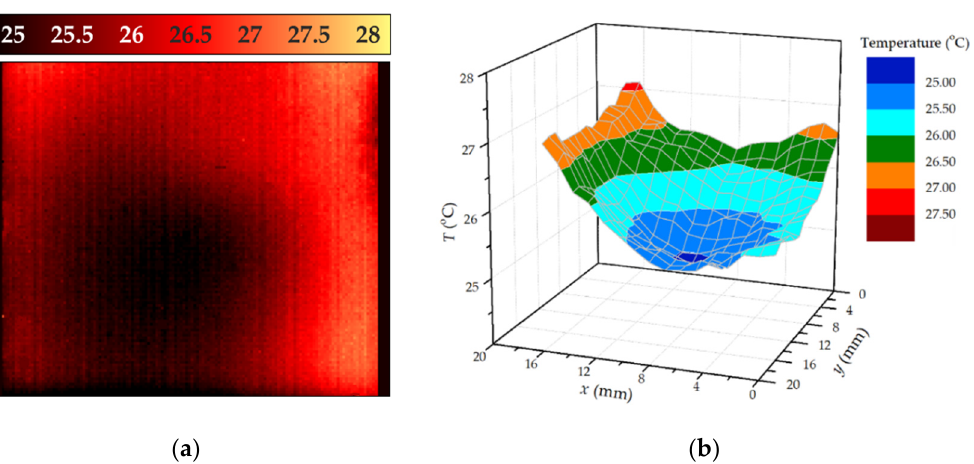
Figure 8. ( a ) The time-averaged IR thermography frame and ( b ) corresponding temperature distribution of the heating during spray cooling ( Q = 1.7 mL/s, q = 45 kW/m 2 ).